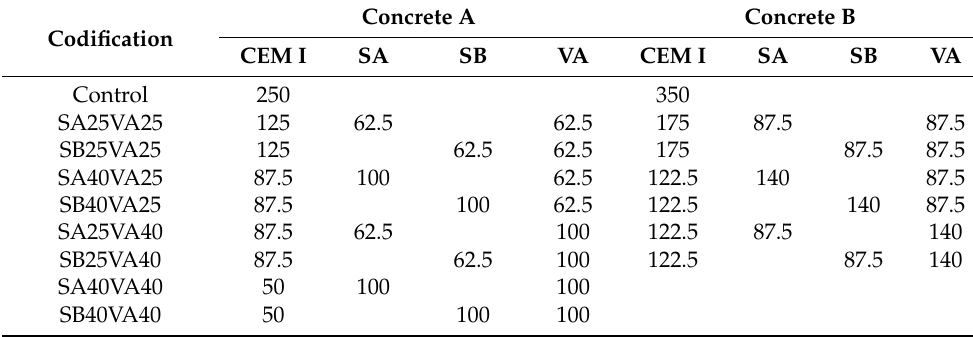
Table 6. Ternary cements composition for each concrete, A & B (kg/m 3